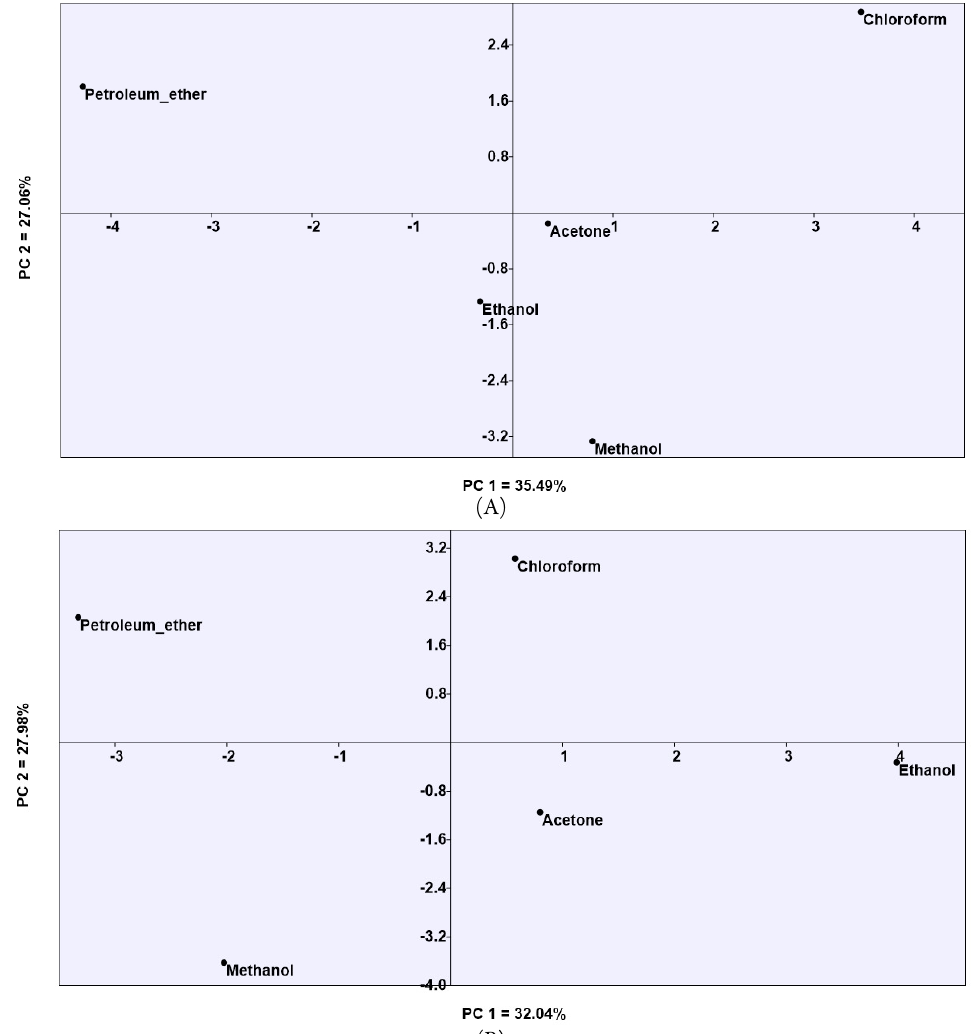
Figure 5. Principal component analysis of metabolites reported in (A) leaves and (B) seeds various solvent